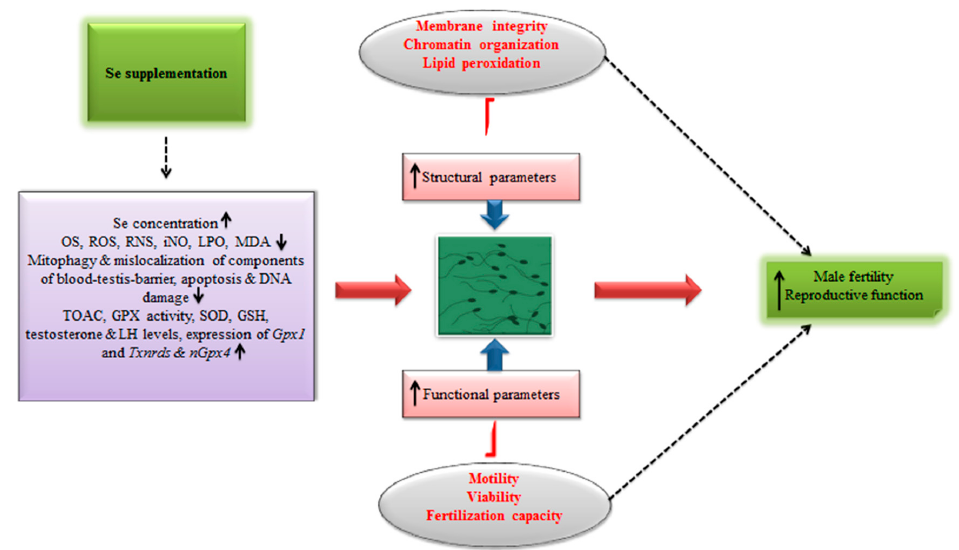
Figure 4. Schematic illustrating the implication of Se supplementation in ameliorating fertility and reproductive efficiency in males.